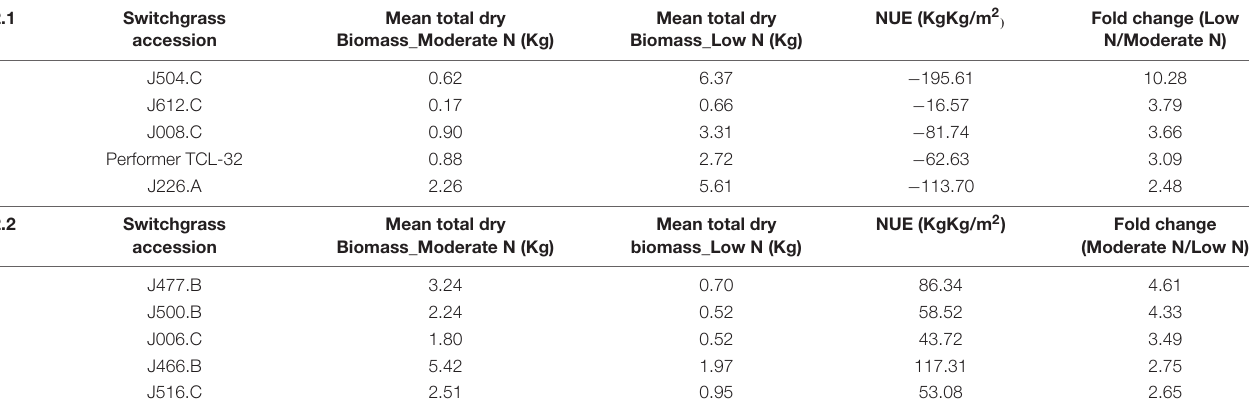
TABLE 2 | Top 10 nitrogen use-efficient switchgrass